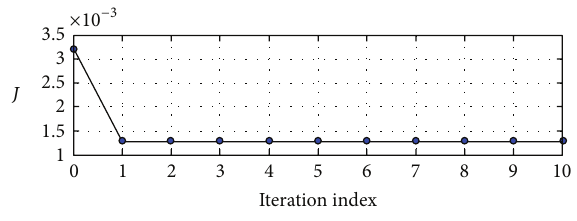
Figure 4: Cost optimization via